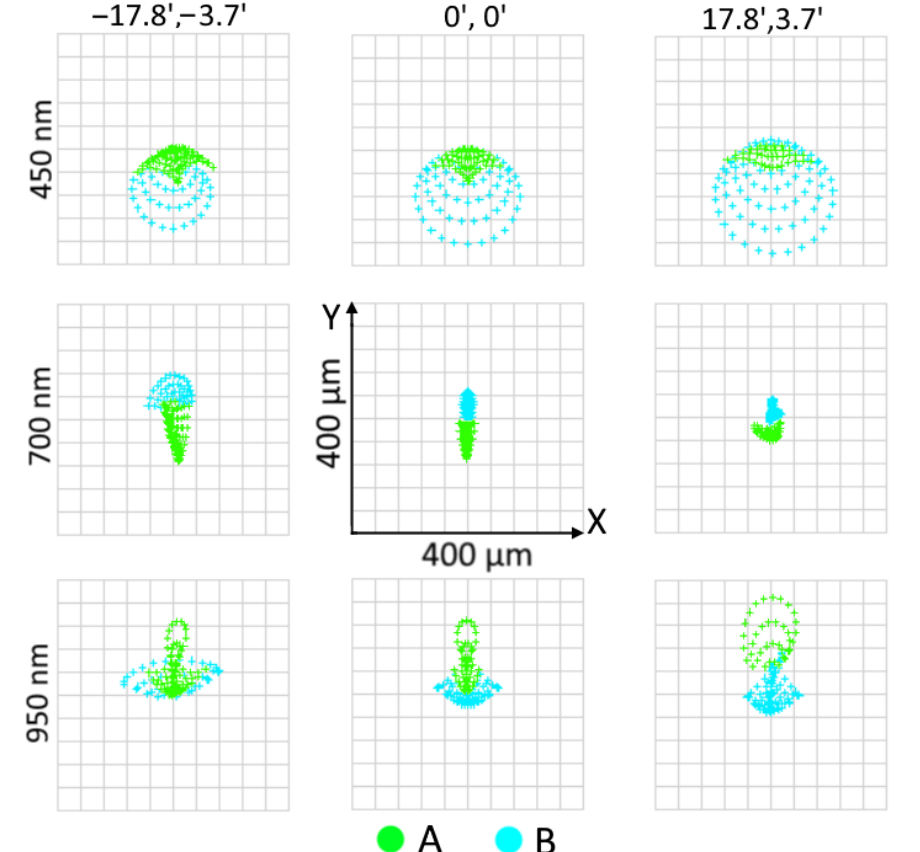
Figure 6. Spot diagrams of the spectrograph with simplified composite grism.